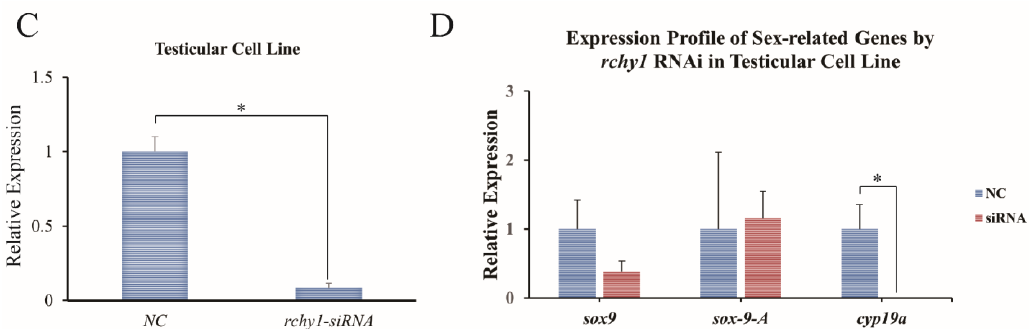
Figure 5. Relative mRNA expression levels of Cs-rchy1 , figla_tv1 , igf1 , sox9 , sox-9-A , and cyp19a in ovarian and testicular cell lines after RNAi treatment. ( A ) Expression of Cs-rchy1 after the transfection of the siRNAs for 48 h in ovarian cell line. ( B ) Expression of figla_tv1 , igf1 , sox9 , sox-9-A , and cyp19a after the transfection of the siRNAs for 48 h. ( C ) Expression of Cs-rchy1 after the transfection of the siRNAs for 48h in testicular cell line. ( D ) Expression of sox9 , sox-9-A , and cyp19a after the transfection of the siRNAs for 48 h. NC, negative control group. siRNA, rchy1-siRNA treated group. Asterisks (*) indicate significant differences ( p < 0.05) between the treated group and the control.